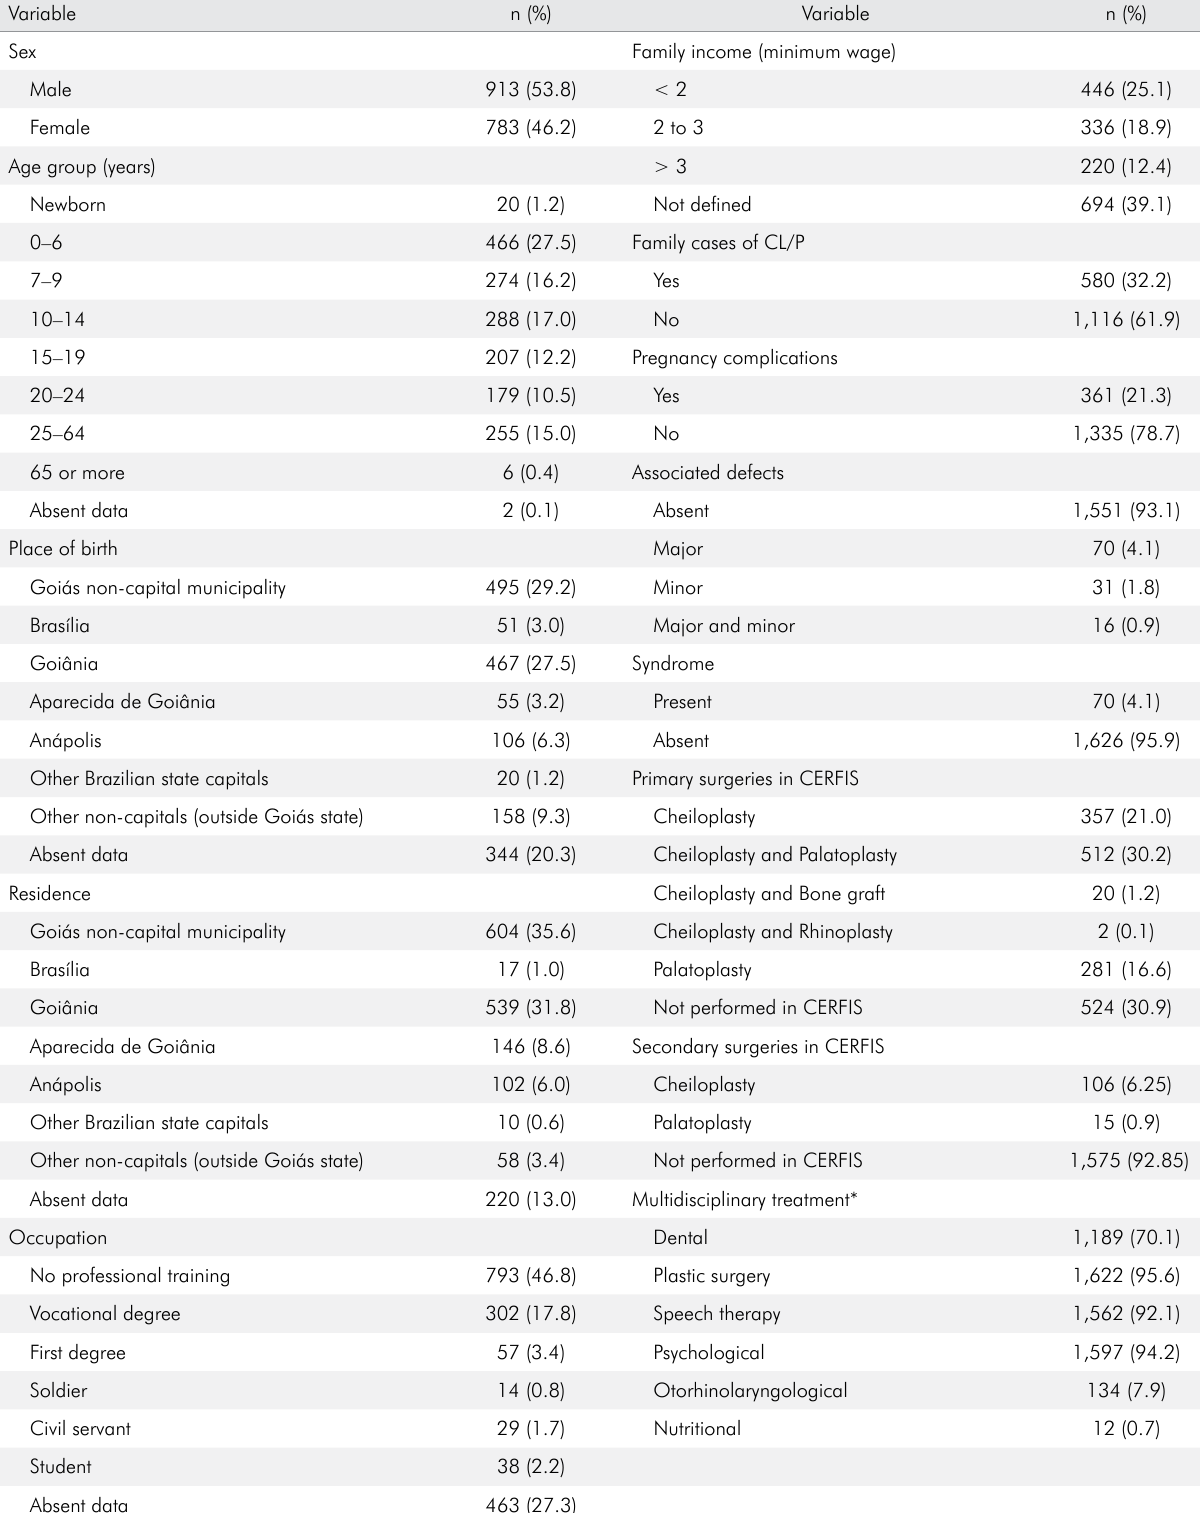
Table 1. Clinical characteristics of the sample (n=